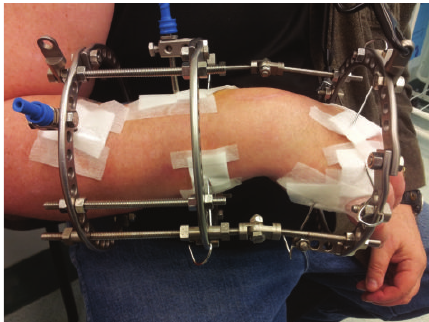
Figure 2: Ilizarov wrist distraction fixator assembly.